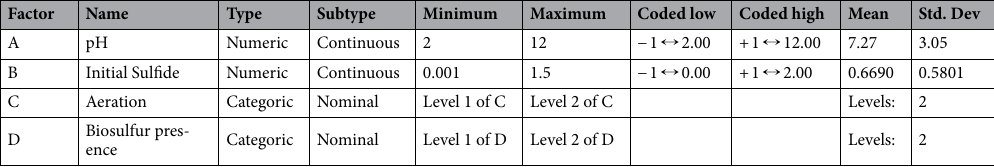
Table 1. Details of factors introduced to D. X.